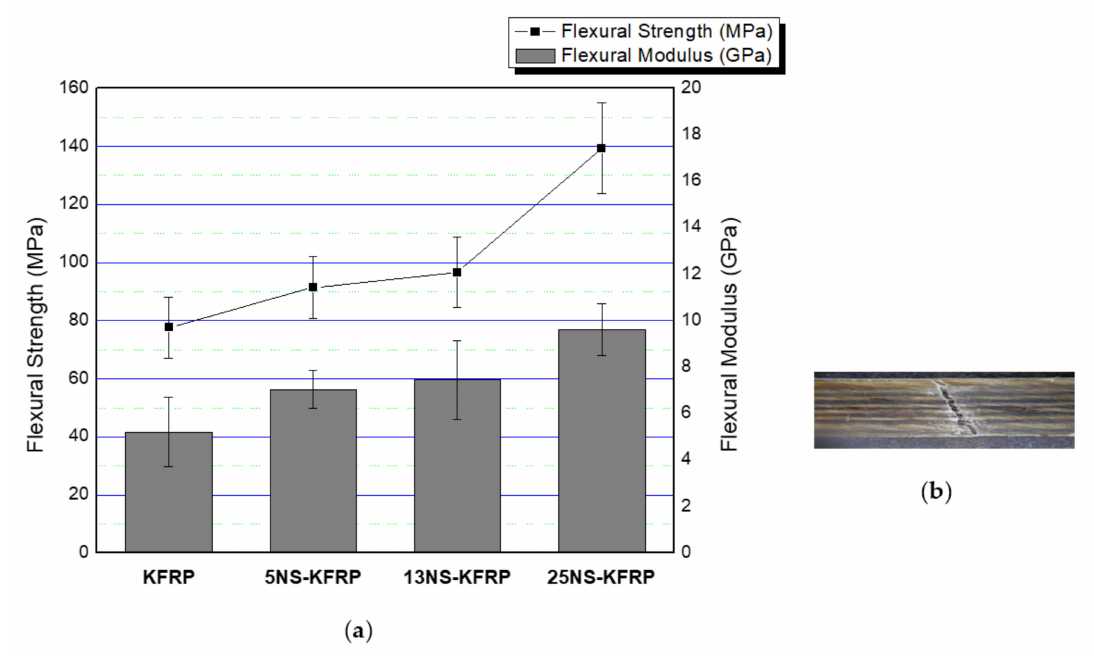
Figure 7. ( a ) Flexural properties of nanosilica-modified KFRP (5NS-KFRP, 13NS-KFRP and 25NS-KFRP) compared with KFRP. ( b ) Example of fractured KFRP samples after flexural test.